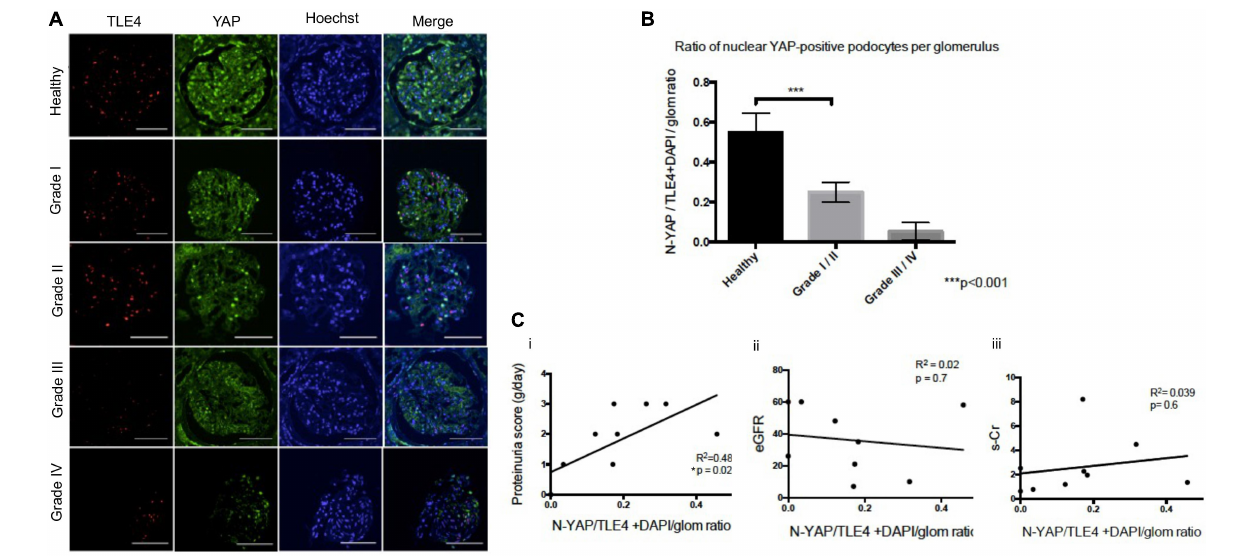
FIGURE 3 | Loss of nuclear YAP correlates with disease severity in Diabetic Nephropathy (A) Representative images of glomeruli from healthy renal cortical tissue and from Grade I–IV Diabetic Nephropathy cases stained with TLE4 (red) as a podocyte nuclear marker, YAP (green) and Hoechst (blue) as a nuclear marker. Magnification: 20 × . Scale bar = 100 µ m. (B) Ratio of YAP-positive nuclei (N-YAP/TE4+DAPI/glom) based on histological classification of disease (Grade I-II vs. Grade III-IV). Values expressed as mean ± SD. *** p < 0.001, Student’s t -test, unpaired. (C) Assessment of the relationship between clinical parameters (proteinuria, eGFR, serum creatinine, hematuria) and ratio of YAP-positive podocyte nuclei. (i) Proteinuria v. N-YAP/TLE4+DAPI/glom ratio, linear regression, * p = 0.024 (ii) Serum creatinine (s-Cr) v. N-YAP/TLE4+DAPI/glom ratio, p = 0.6 (iii) Estimated glomerular filtration rate (eGFR) v. N-YAP/TLE4+DAPI/glom ratio, p = 0.7. Correlation between variables was evaluated by least-squares linear